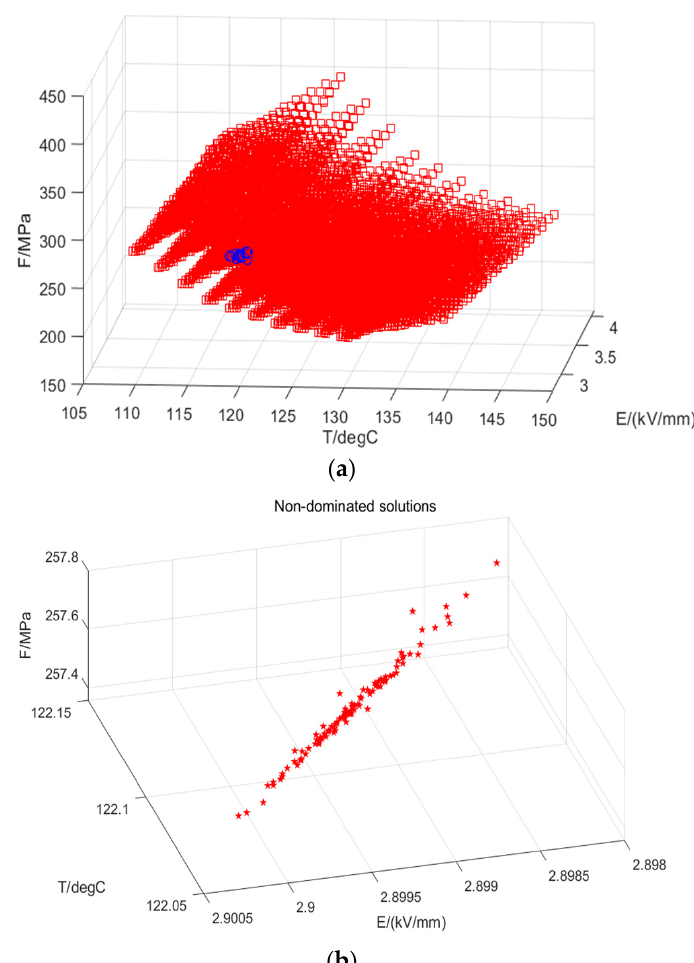
Figure 11. Maximum electric field, temperature, and mechanical stress in the original population and optimized populations: ( a ) original population (red circle) and optimized population (blue circle); ( b ) Pareto frontier of the optimized population.